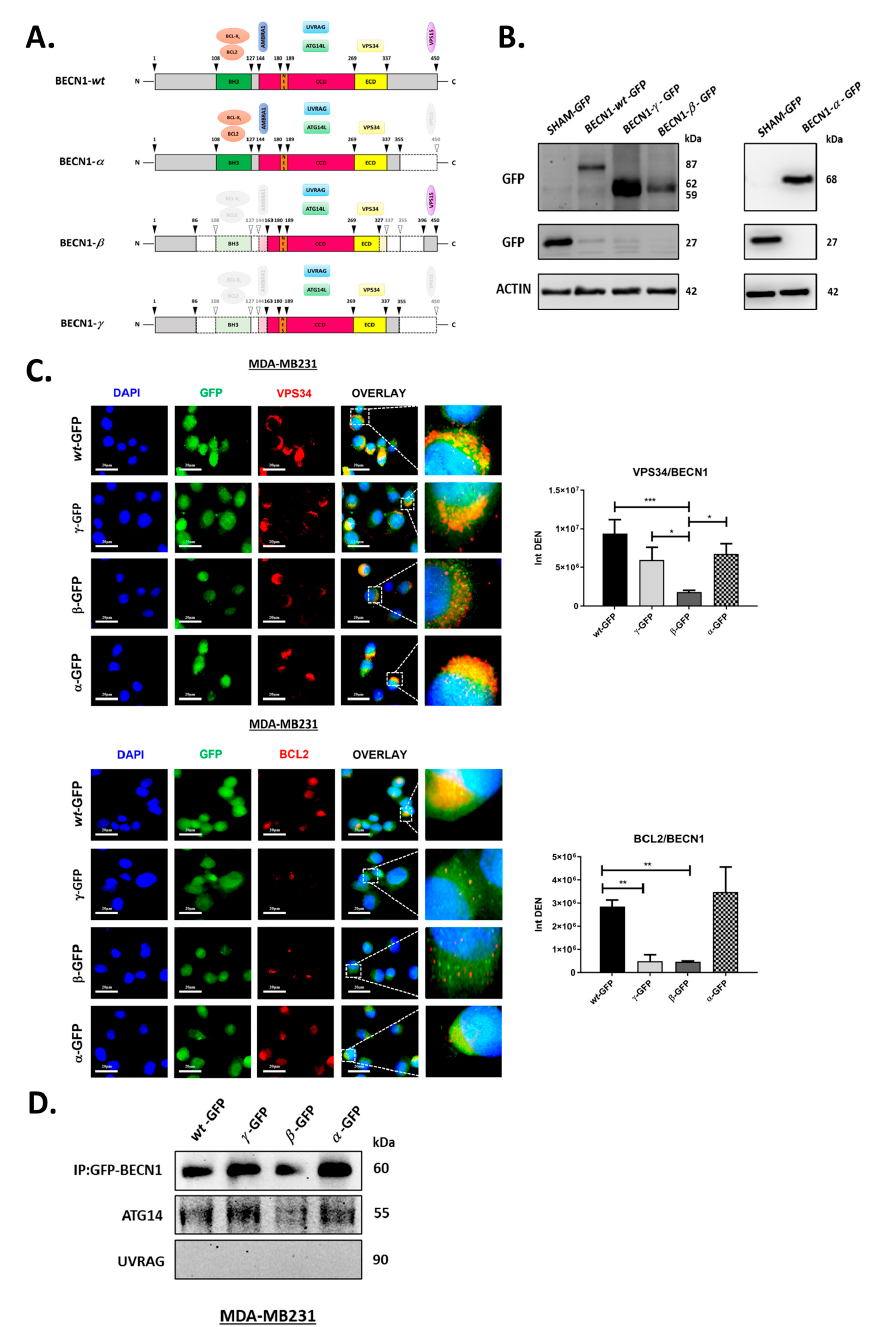
Figure 3. BECN1 isoforms show different alterations in their interactions with VPS34 and BCL2 while maintaining their ability to bind to ATG14. ( A ) Schematic representation of BECN1 isoforms primary protein structure and domains. BECN1 domains and interacting proteins investigated in this